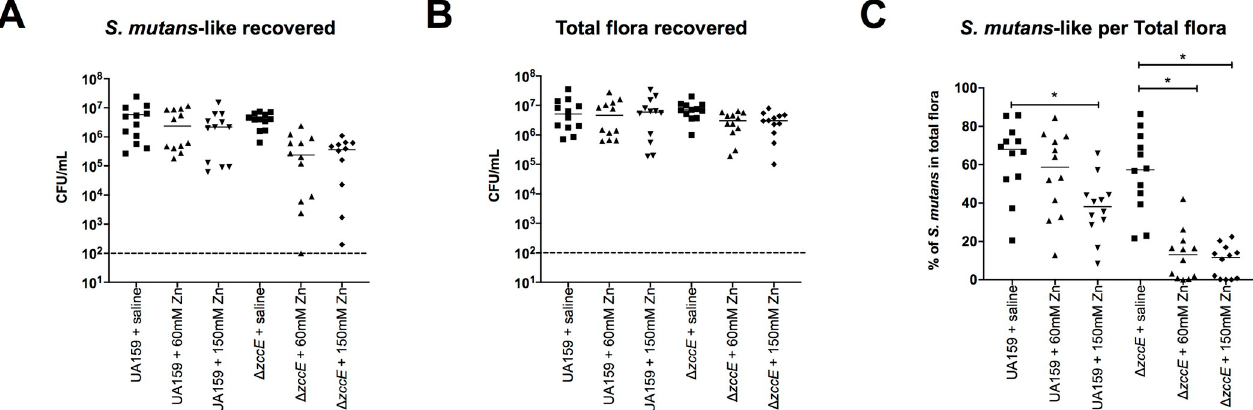
Fig 10. Colonization efficiency of S . mutans UA159 or Δ zccE on the teeth of rats after topical treatment with Zn. (A-B) Bacterial CFU recovered from rat jaws by plating on (A) MS agar for S . mutans and (B) blood agar for total flora. (C) Percentage of S . mutans -like colonies over total flora were calculated by dividing the values shown in (A) by those shown in (B). The dashed line indicates the limit of detection. One-way ANOVA was used to determine significance, and only statistically significant comparisons with p value < 0.05 ( � ) are indicated in the